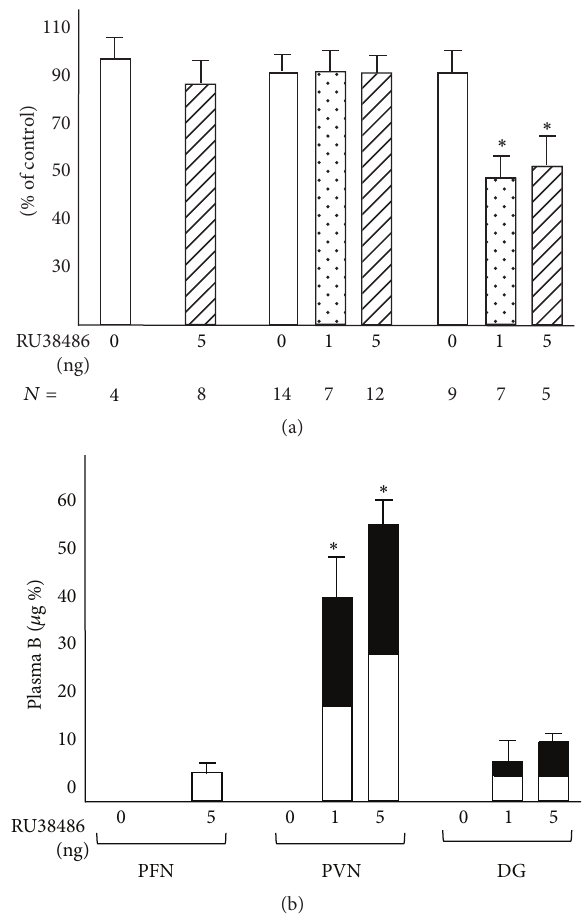
Figure 4: (a) Effect of local intracerebral injection of RU38486 at 5 min prior to initial test on retention of acquired immobility (top) and (b) plasma CORT level (bottom). Behavioural data are expressed as percentage (mean ± the standard error of the mean) of the value observed in rats injected with vehicle. Endocrine data are expressed as micrograms CORT per 100mL plasma. Open areas represent control injections and closed areas the CORT levels after administration of RU38486. The number of animals is indicated in the figure. The figure comes from de Kloet et al. [17]. ∗ 𝑃 < .01 as compared to controls. PFN is thalamic parafascular nucleus; PVN is hypothalamic paraventricular nucleus; DG is dentate gyrus. Adapted and reprinted with permission from